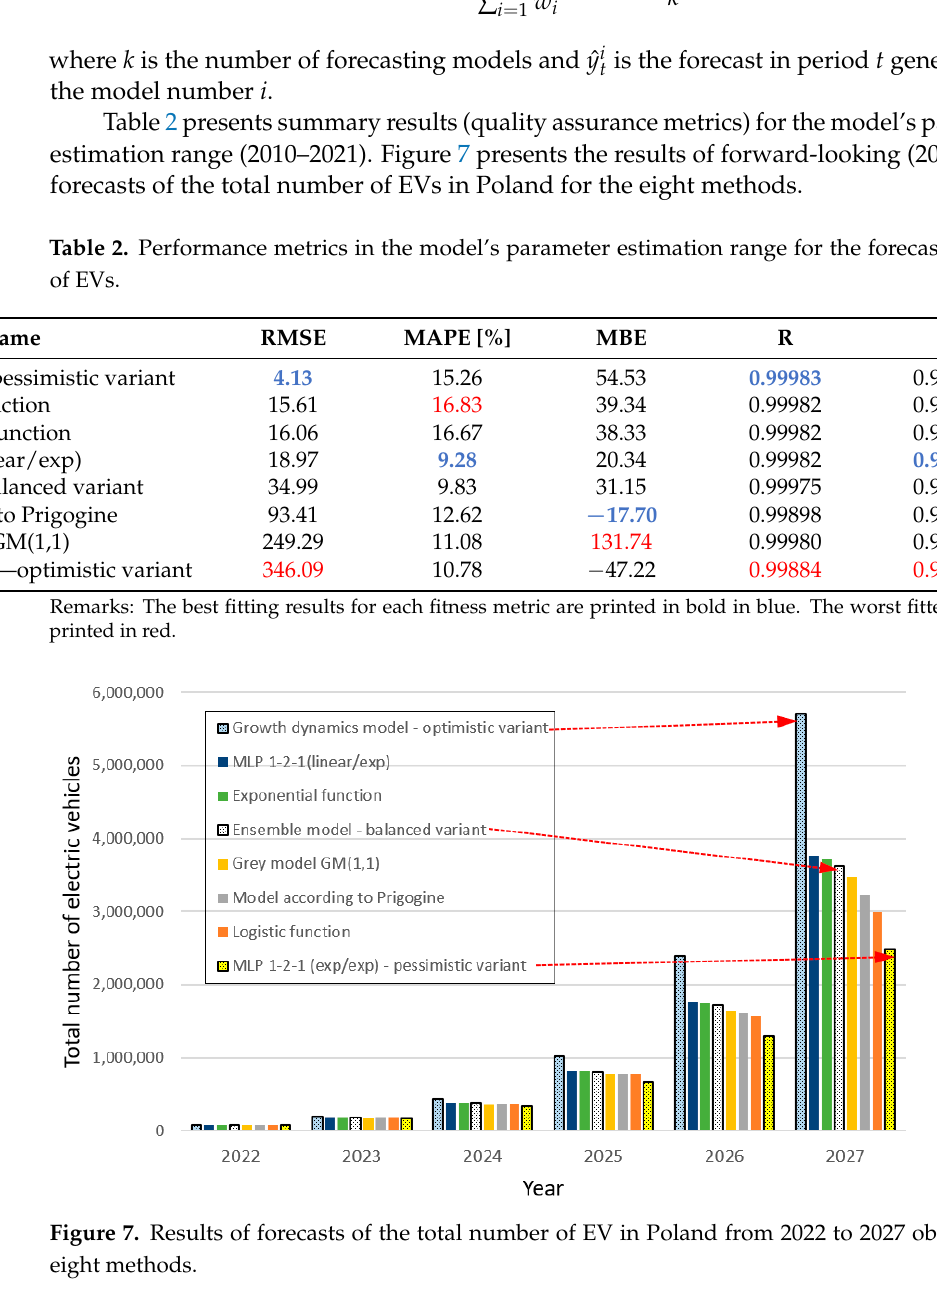
Table 2. Performance metrics in the model’s parameter estimation range for the forecast number of EVs.